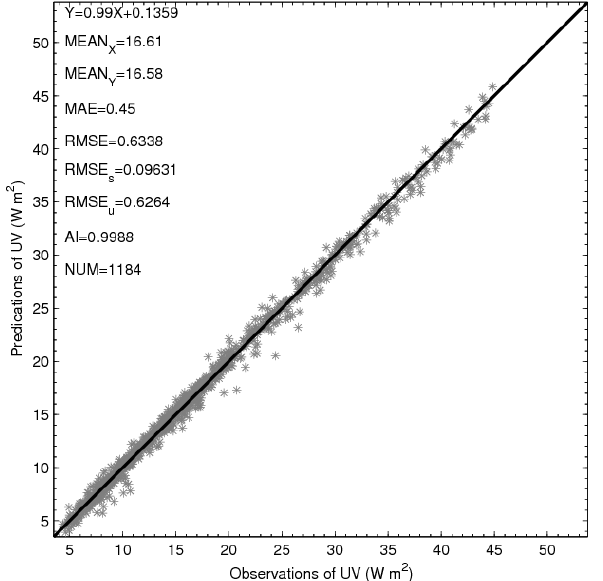
Fig. 5. Scatterplot of UV radiation between observation and model Figure 5. Scatterplot of UV radiation between observationand model estimation. The estimation. The black line represents the 1:1 relationship; also in- black line represents the 1:1 relationship; also included are an array of complementary cluded are an array of complementary difference and univariate in- dices. The results were obtained using 25% of data reserved for difference and univariate indices. The results were obtained using 25% of data validation. reserved for validation.